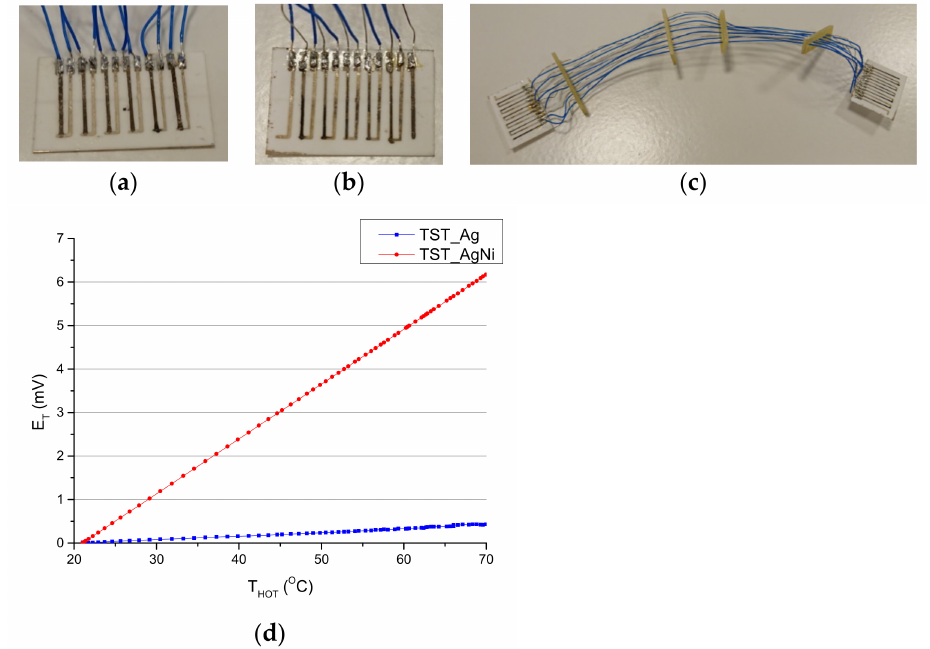
Figure 9. Sensor prototypes: ( a ) TST_Ag fabricated using only silver wires (zoom of “hot” substrate); ( b ) TST_AgNi fabricated using silver and nickel wires (zoom of “cold” substrate); ( c ) TST_AgNi—the whole sensor; ( d ) output signal of TST_Ag and TST_Ni vs. temperature of “hot”